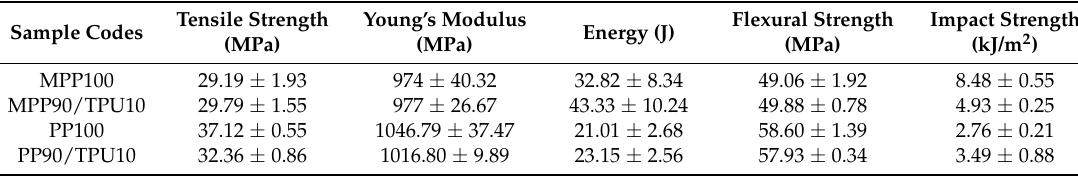
Table 2. Mechanical properties of PP/TPU and MPP/TPU blends.